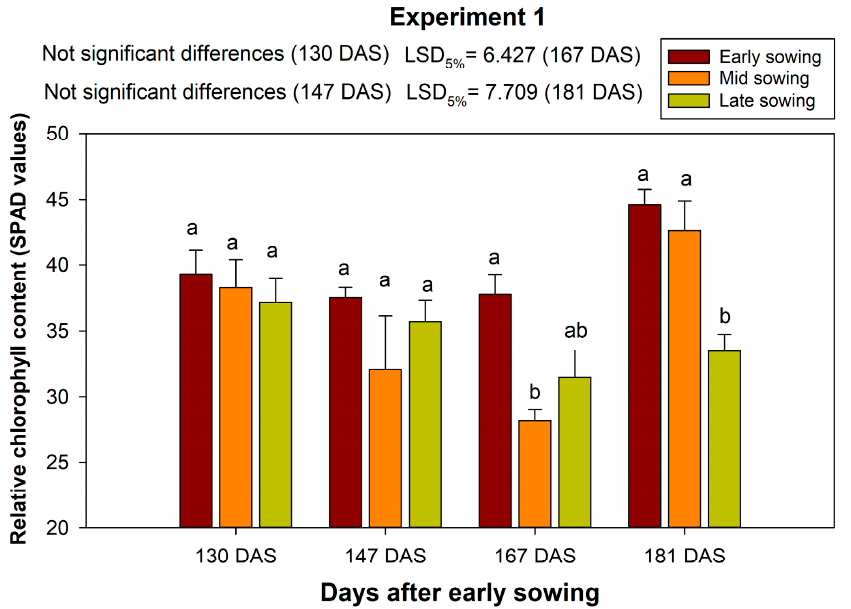
Figure 2. Relative chlorophyll content (SPAD values) in the leaves of bristly oxtongue as affected by sowing date (early, mid, and late). For each sampling date, bars followed by the same letters were not found to significantly differ with Fisher’s least significant difference (LSD) test. Errors bars show the Standard Error values. Final measurement (source of variation: treatments): Fvalue = 9.139, p = 0.032, DF (degrees of freedom) = 2.